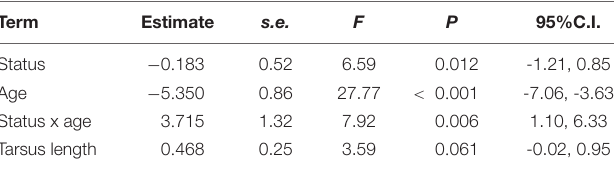
TABLE 5 | Results of LMMs for tail length of common kestrel males as a function of dispersal status (immigrant vs. resident), age (young vs. adult), and the interaction between dispersal status and